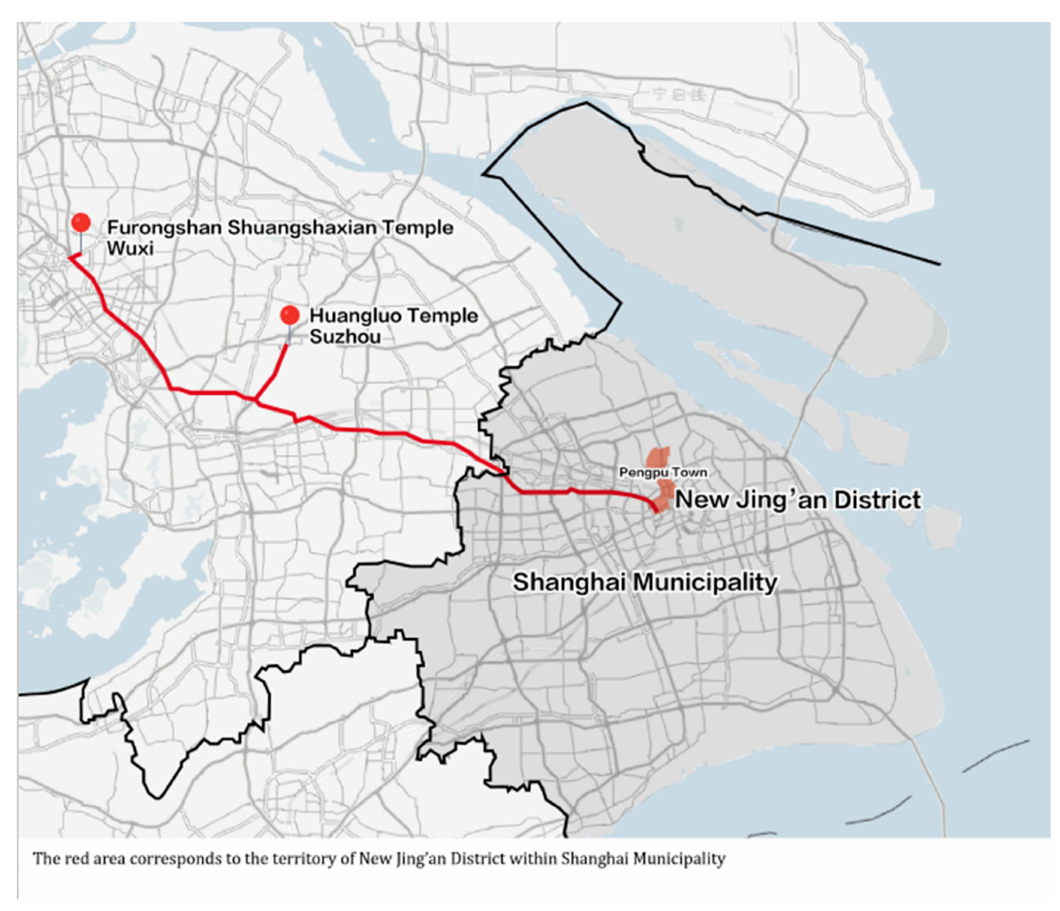
Figure 2. The Compounds in